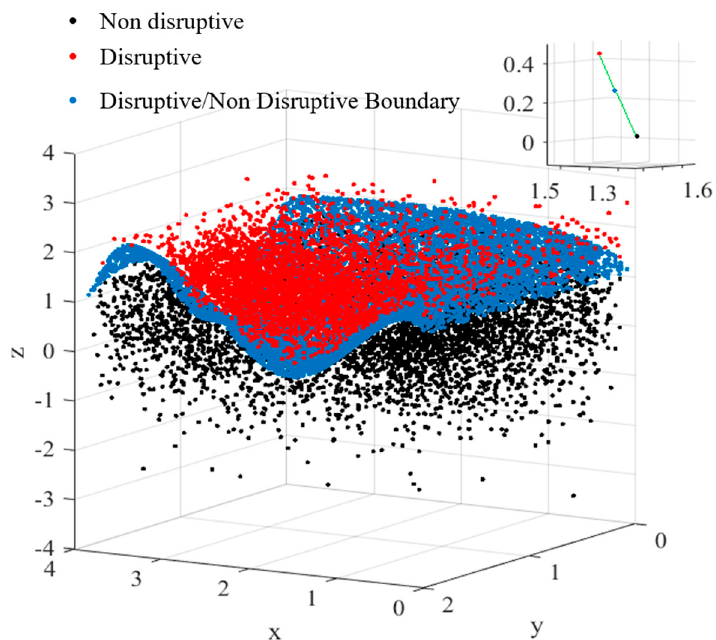
Figure 3. Hypersurface points for a synthetic data set. The black and red points belong to the two classes. The blue points are the ones lying of the hypersurface, obtained with the method explained in the text and illustrated pictorially in the insert.